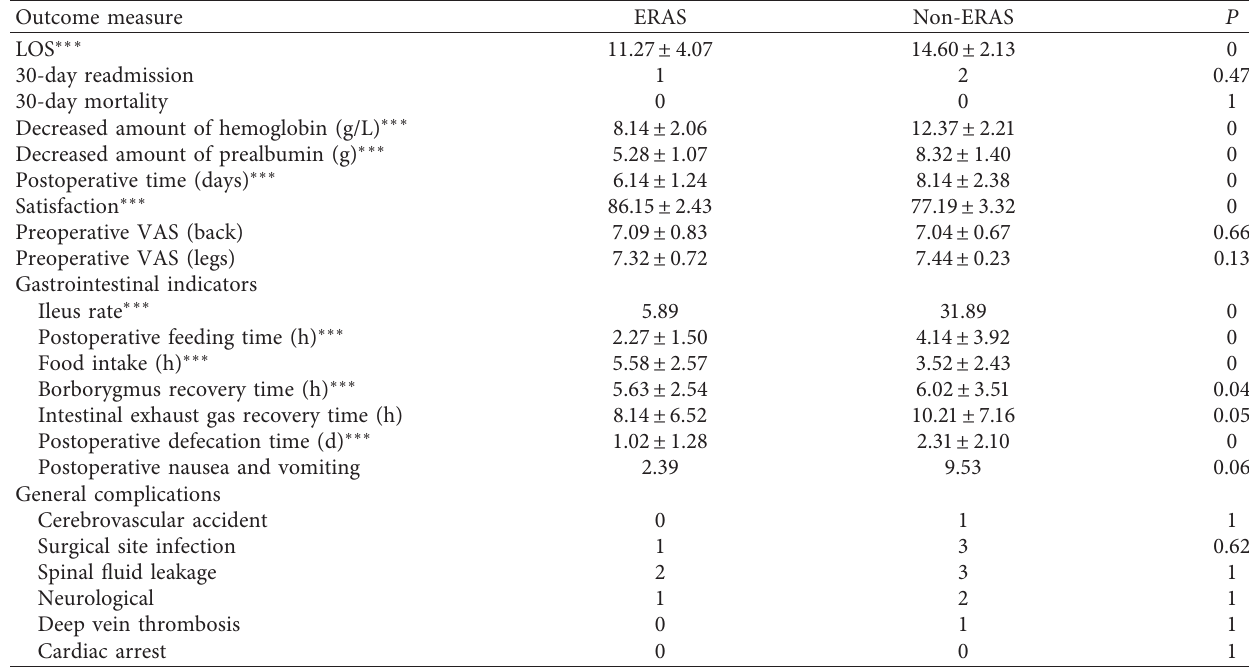
Table 3: Postoperative outcomes.